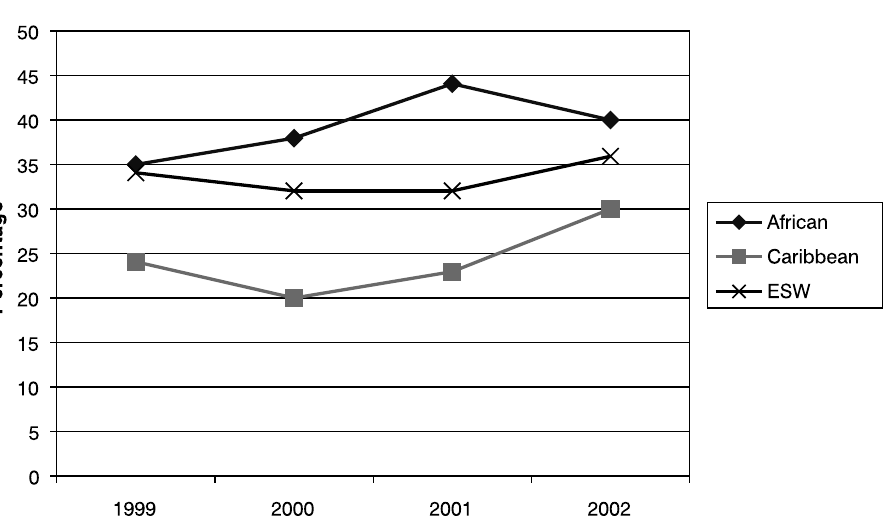
Figure 4. Performance gaps of main ethnic groups at GCSE (%